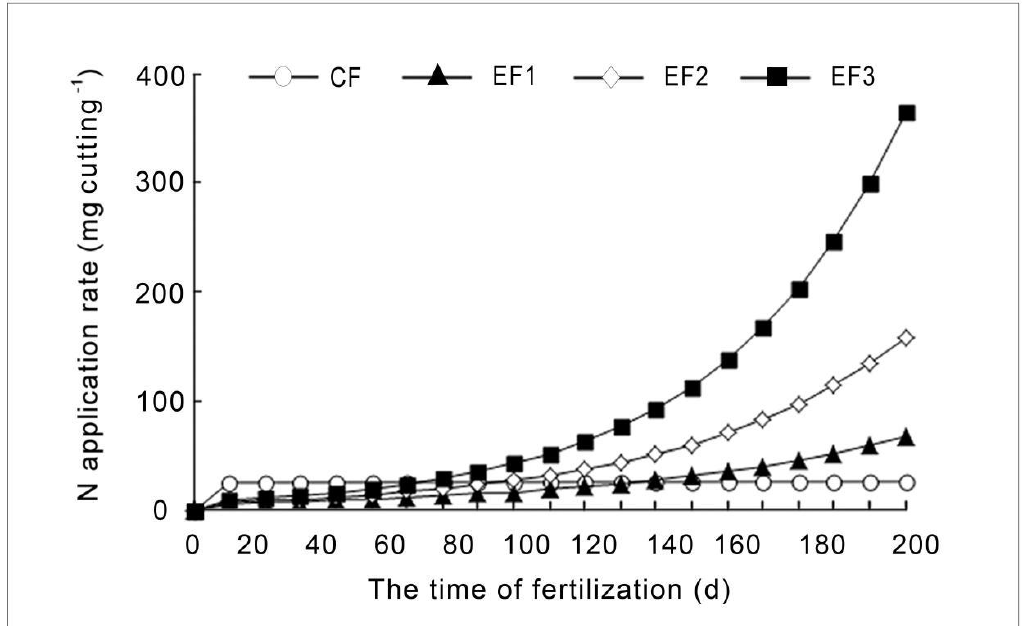
Figure 1. Fertilization at different application levels.